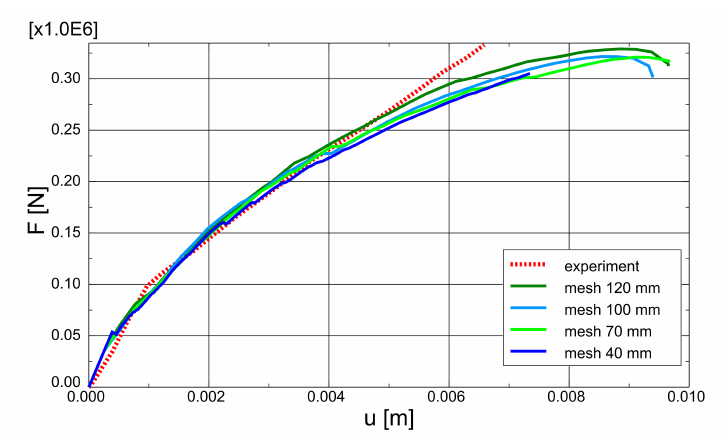
Figure 24. OA-1 beam—mesh dependency